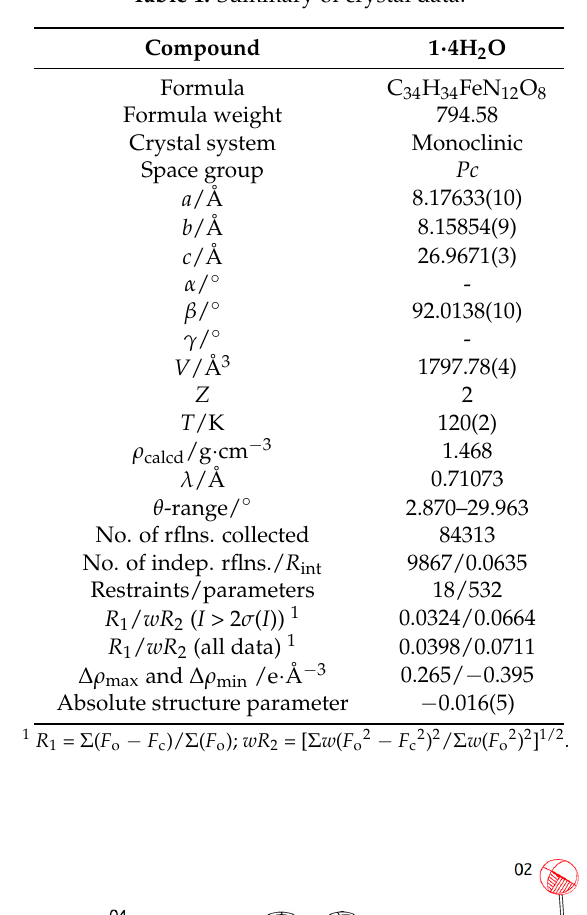
Table 1. Summary of crystal data.